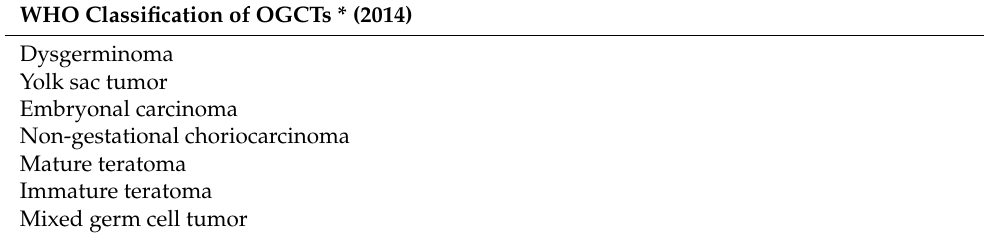
Table 2. World Health Organization classification of OGCTs (2014). WHO Classification of OGCTs * (2014)